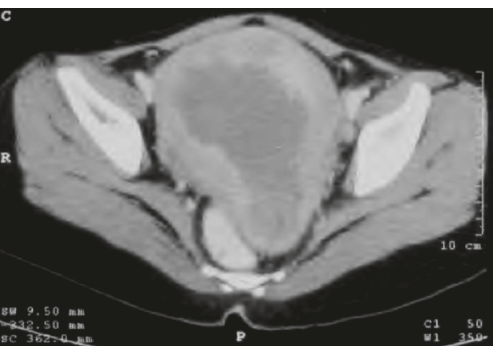
Figure 1: Computed tomography of the abdominopelvic region shows an enlarged well-defined border uterus with diffused enhancing thickening in the endometrial cavity.